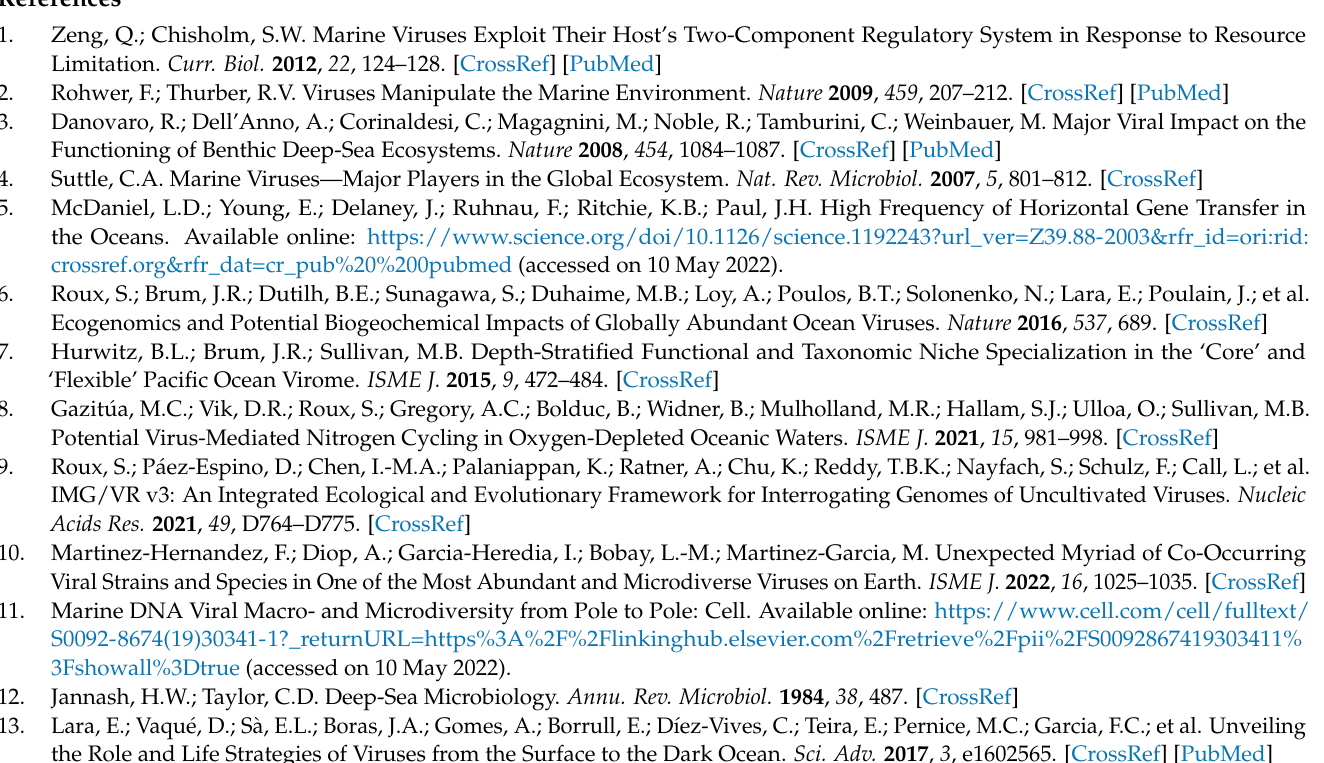
Table S3: AMGs; Table S4: Related viruses to vSAGs; Table S5: Related